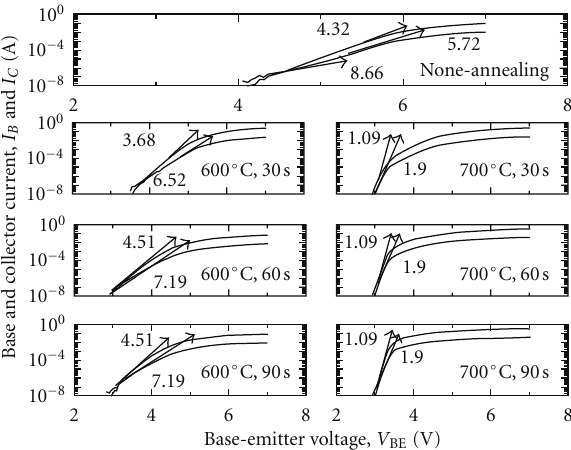
Figure 3: Gummel plots for all fabricated npn graded-base AlGaN/GaN HBT’s.